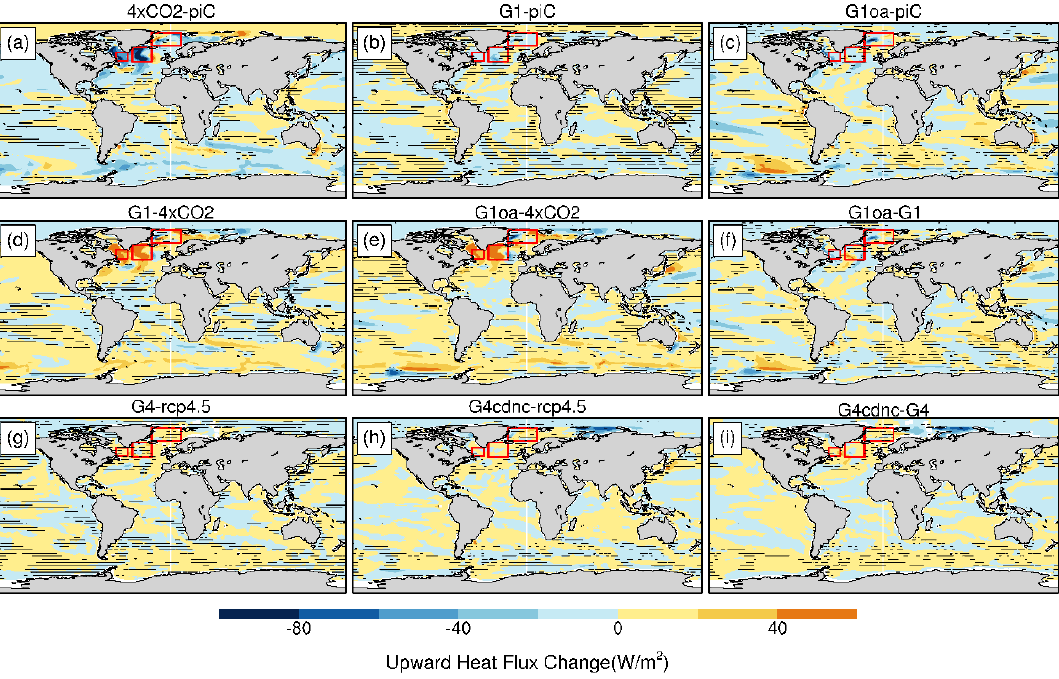
Figure 6. Upward heat flux change (Wm − 2 ) in different scenarios (11–50years). The red boxes mark the three deep convective regions in the northern North Atlantic (from left to right: Labrador Sea, Irminger Sea and Nordic Seas (often referred to as the Greenland–Iceland– Norwegian (GIN) Seas). Yellow to orange colors represent an increase in heat flux from the ocean to the atmosphere. Stippling indicates regions where differences are not significant at the 95% level according to the Wilcoxon signed-rank